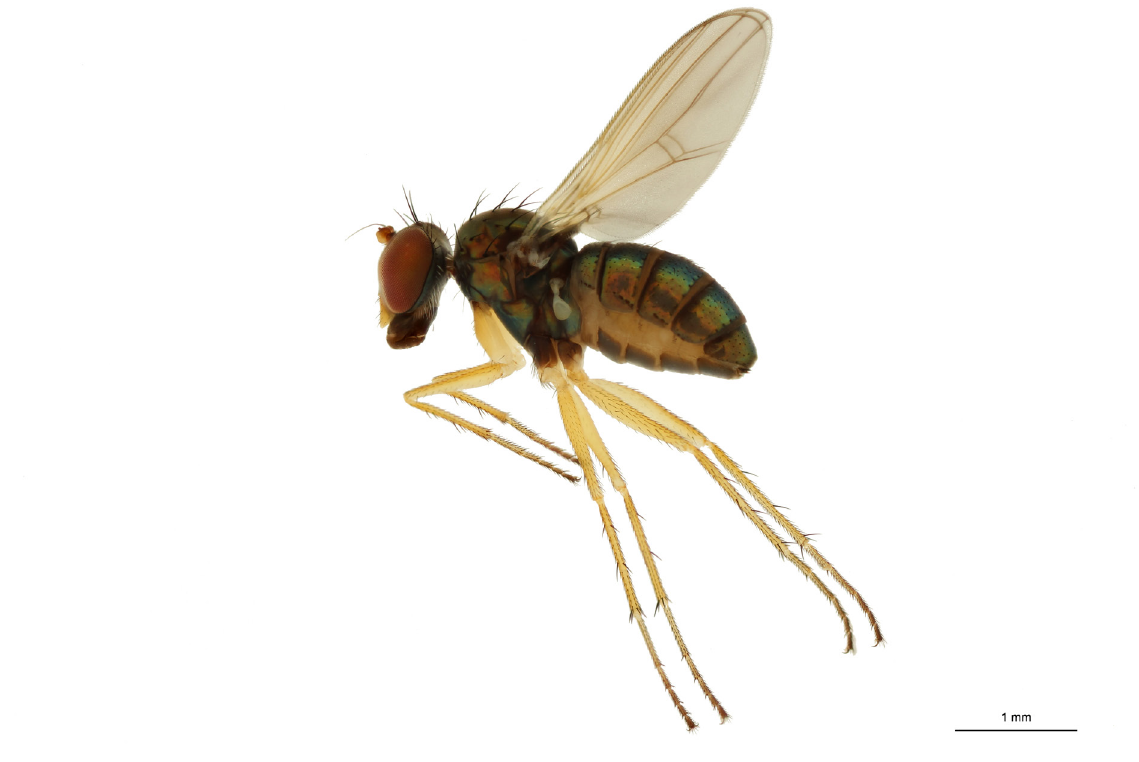
Fig. 3. Thinophilus inaequalis Samoh & Grootaert sp. nov. Female habitus (Abdulloh Samoh leg., PSUNHM